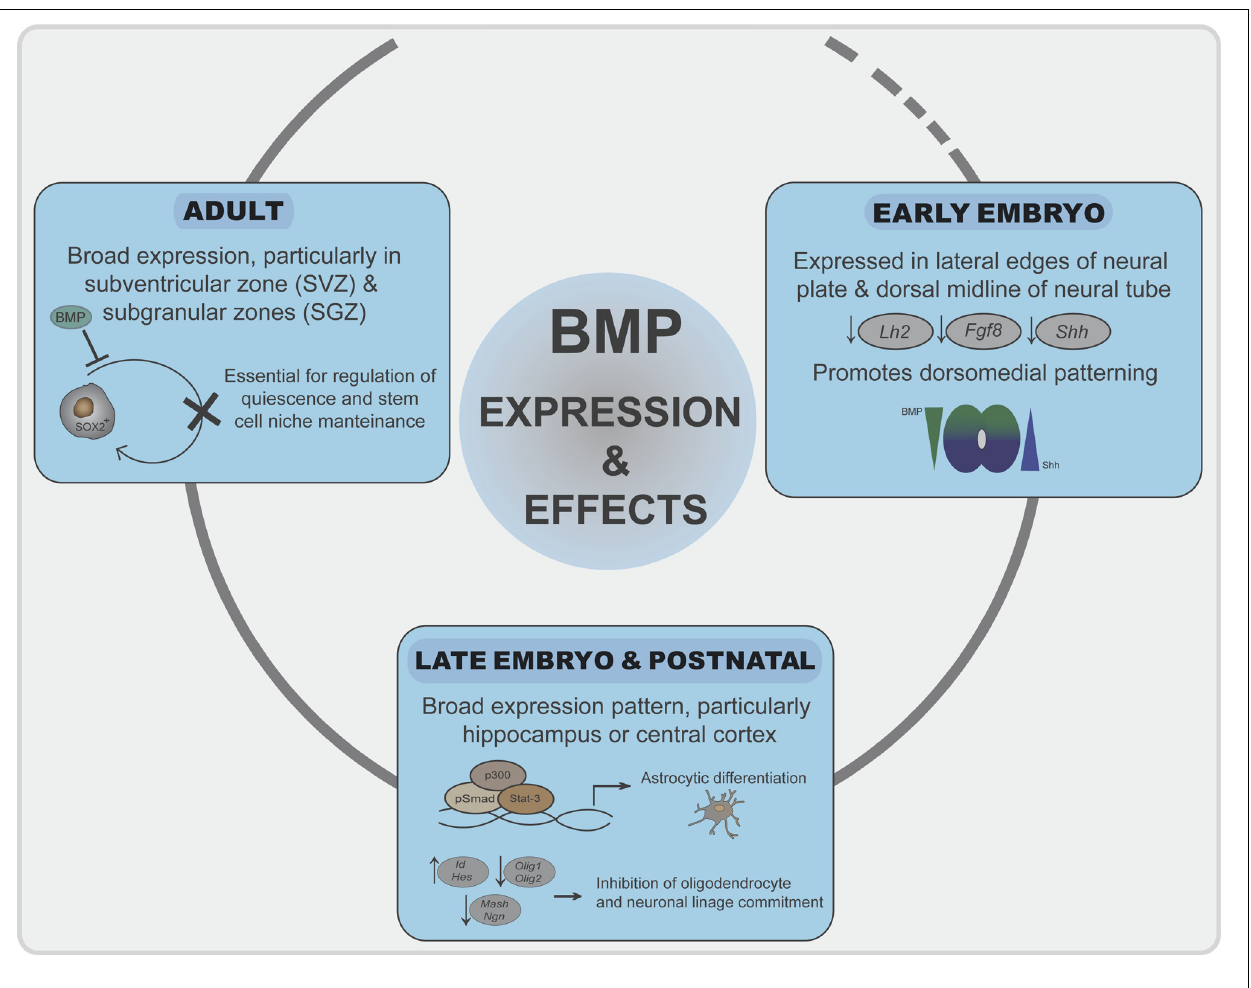
signaling promotes astroglial commitment by activation astrocyte-specific promoters through a Stat3-p300/CBP-Smad1 complex. At the same time represses commitment to the other two neural lineages by inducing Ids and Hes proteins. In adulthood, a balanced BMP signaling is required for regulation of quiescence and differentiation of neural stem cell populations in the SVZ and